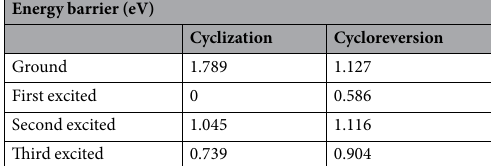
Table 1. Energy barrier of each PES from the two-dimensional PES